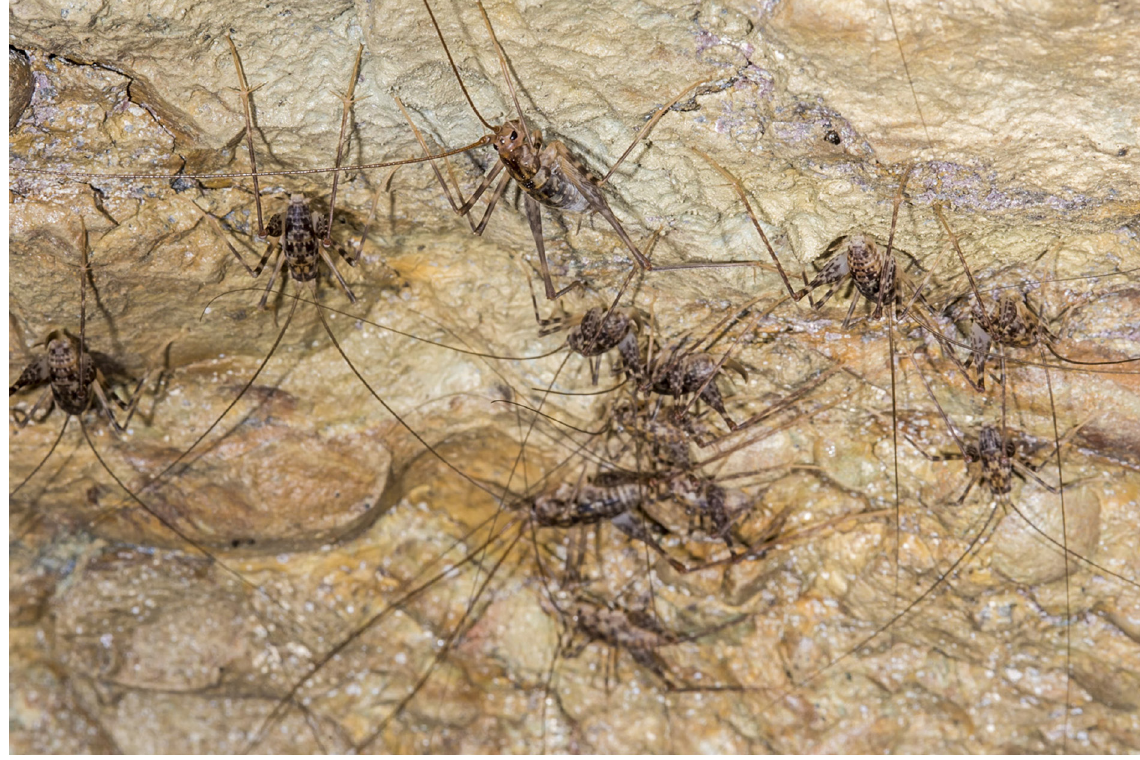
Fig. 20. Tangle of Pleioplectron thomsoni (Chopard, 1923) comb. nov. on cave ceiling. Trotters Gorge,